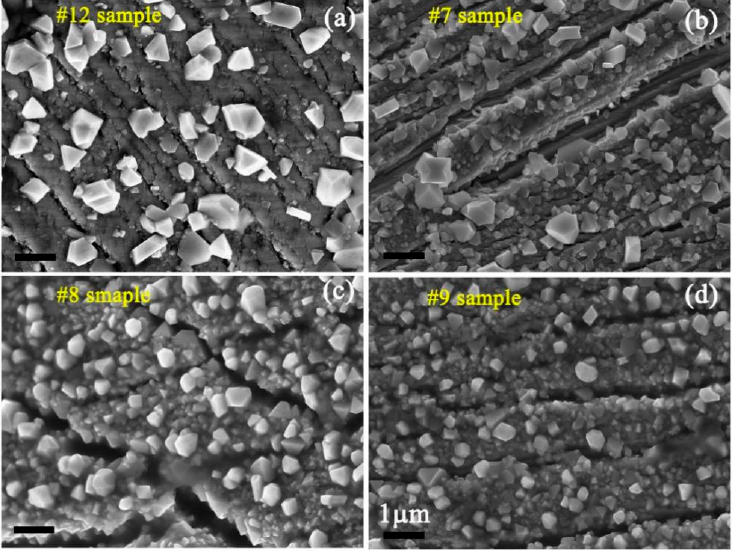
Figure 5. SEM images showing the surface morphologies of ( a ) #12 sample; ( b ) #7 sample; ( c ) #8 sample; and ( d ) #9 sample after the SSRT test.